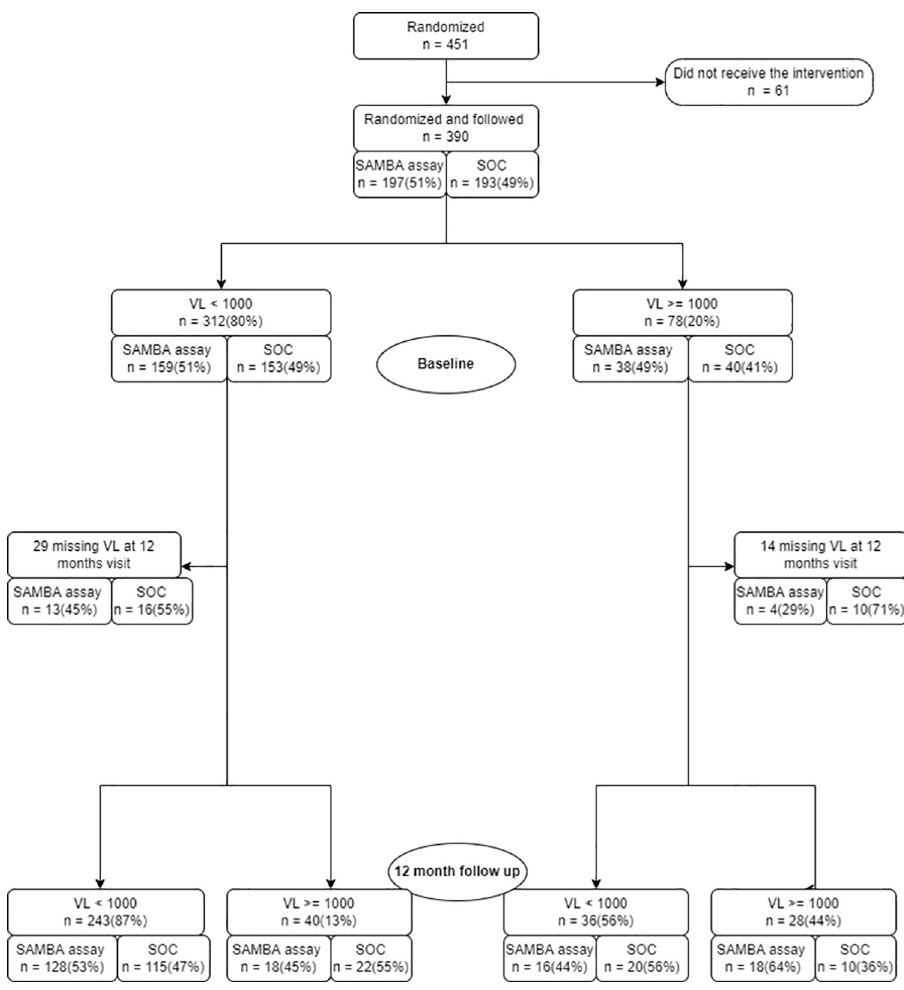
Fig 2. Viral load suppression cascade.